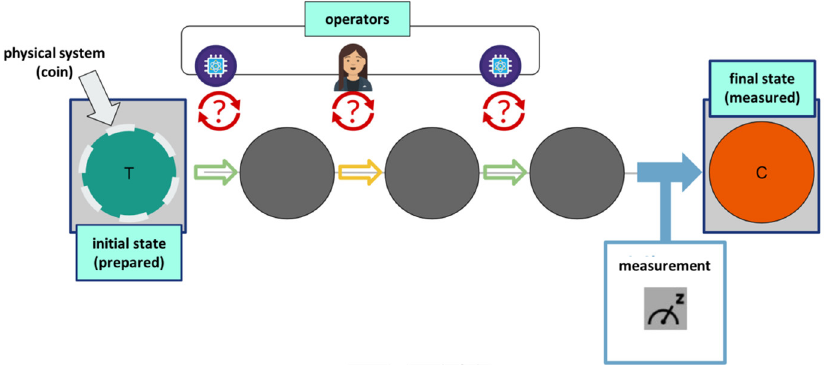
Figure 2. First lecture: the quantum coin flip. Schematics of the quantum coin flip “thought” game interpreted in terms of state preparation, evolution and measurement. One coin is initially prepared in a given state (T, i.e., Head here). After a number of flips by either the quantum computer (displayed as a chip) or the human operator, a measurement is performed (here, yielding C, i.e., Tail). In the second lecture, we introduce the use of the IBM Q-composer [21] to write and execute quantum circuits on simulators and real quantum computers (Figure 3).